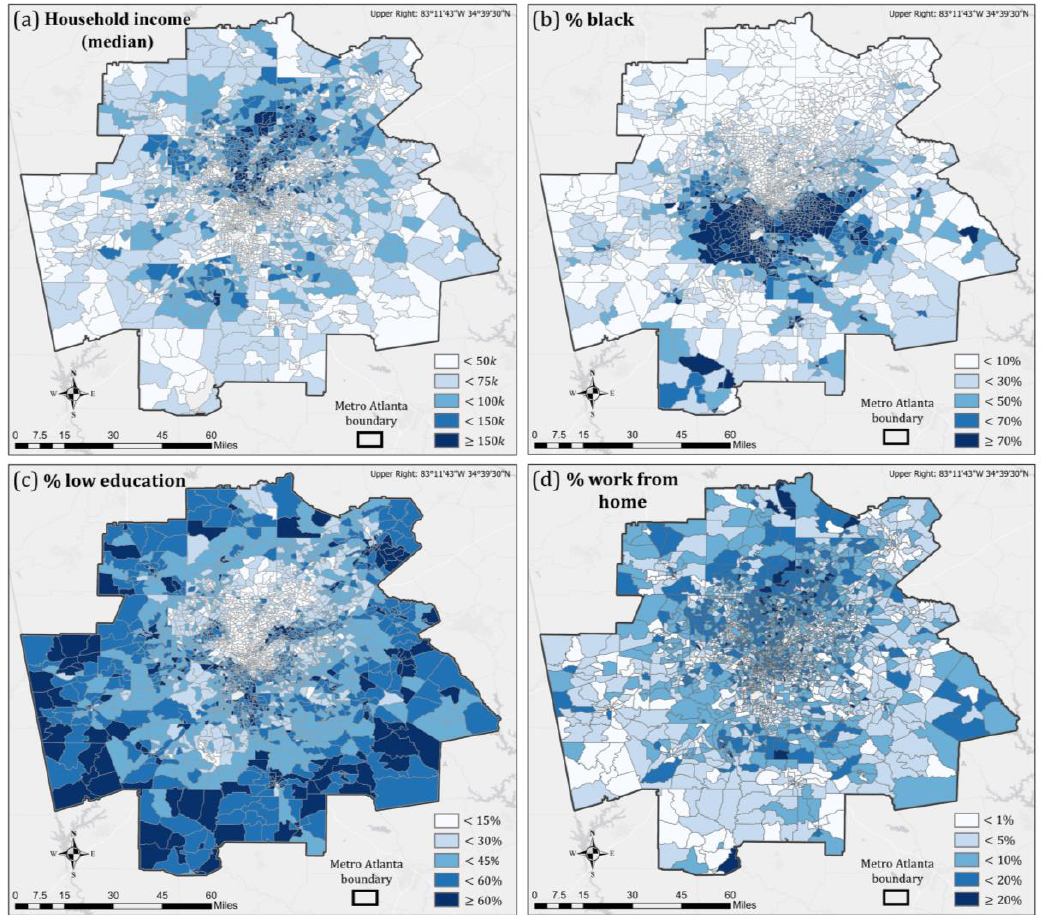
Figure 3. Profile of Metro Atlanta with four selected variables. ( a ) Median household income; ( b ) Percentage of black; ( c ) Percentage of low education (education equal or less than high school); ( d ) Percentage of workers who work from home. All statistics are derived from the ACS 2014–2018 estimates. CBG boundaries are derived from 2019 TIGER/Line Shapefiles.